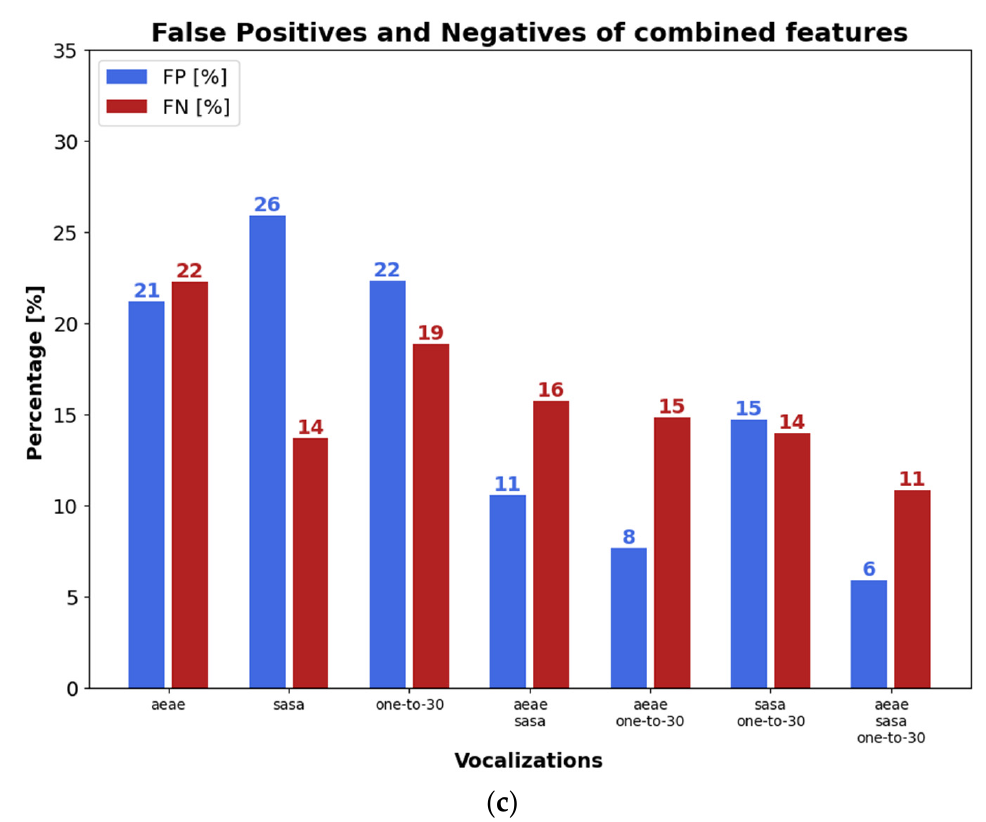
Figure 6. FP and FN with single and combined classifiers: ( a ) time ‐ independent features; ( b ) time ‐ dependent features; and, ( c ) combined time ‐ independent and time ‐ dependent features.